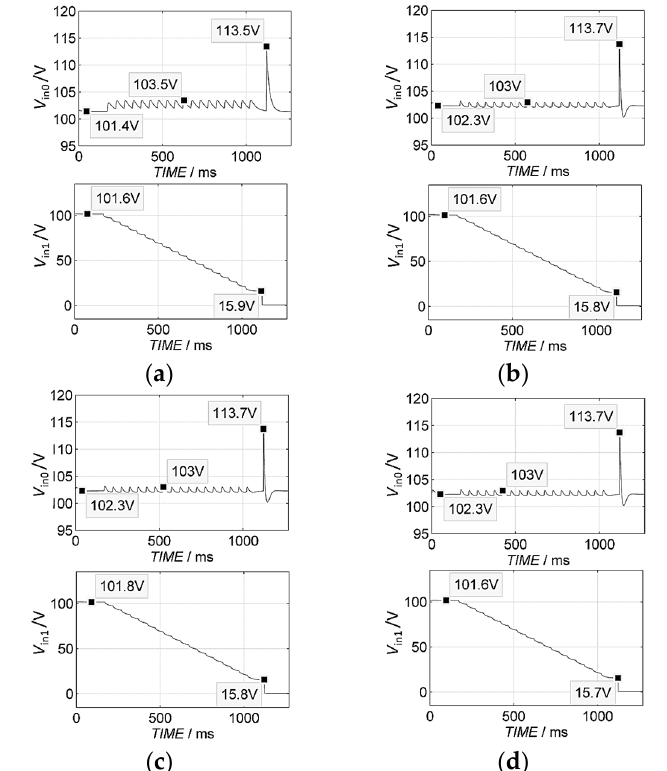
Figure 12. The simulated results with the loads of ( a ) 0 W, ( b ) 25 W, ( c ) 50 W, and ( d ) 75 W, respectively (2 modules).